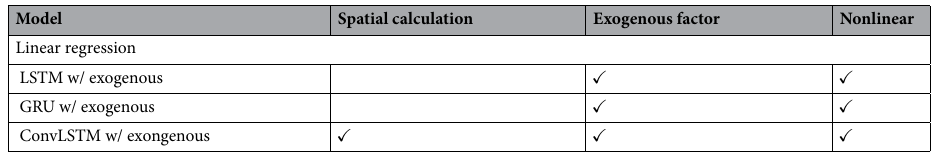
Table 5. Comparison of forecasting methods. Spatial calculation indicates whether the method performs spatial calculations. Exogenous factor indicates whether the method considers exogenous factors. Nonlinear refers to whether the method is